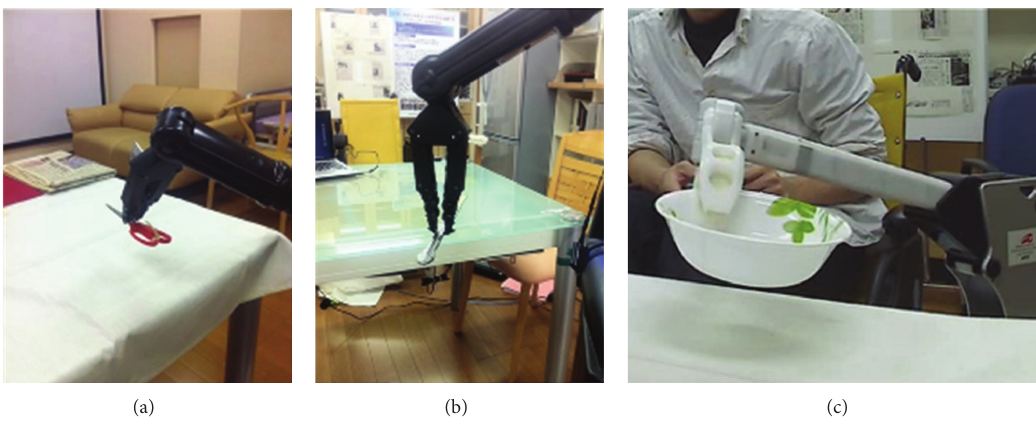
Figure 9: Evaluation experiment of assistive robotic arms